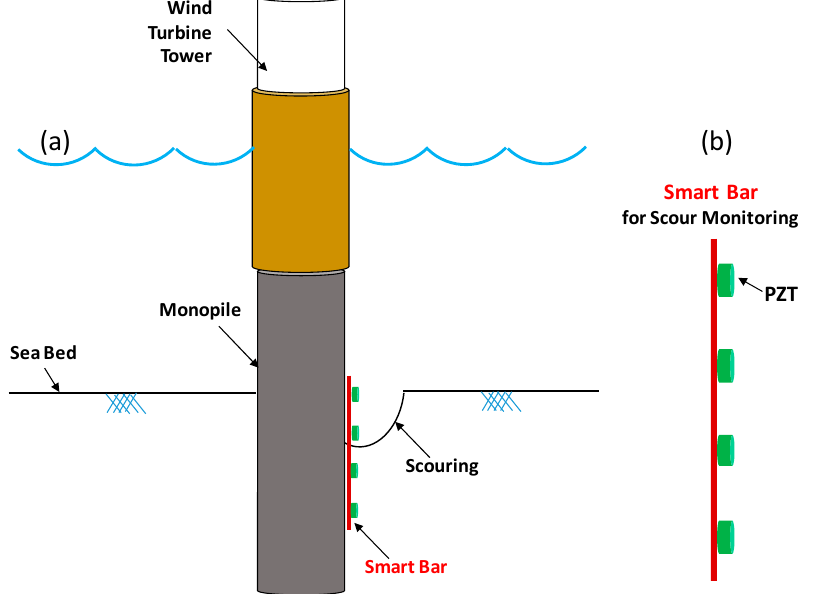
Figure 21. ( a ) Proposed impedance-based scour monitoring of a wind turbine foundation; ( b ) smart bar prototype for scour monitoring.